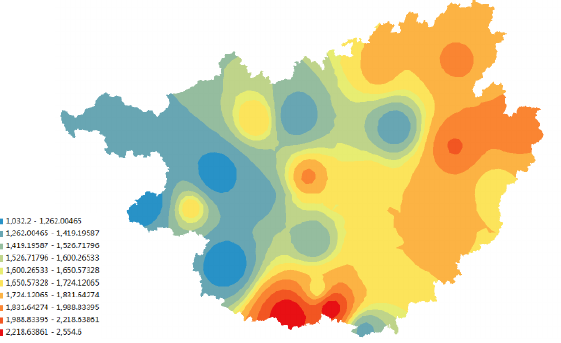
Figure 5. Distribution map of rainfall in Guangxi